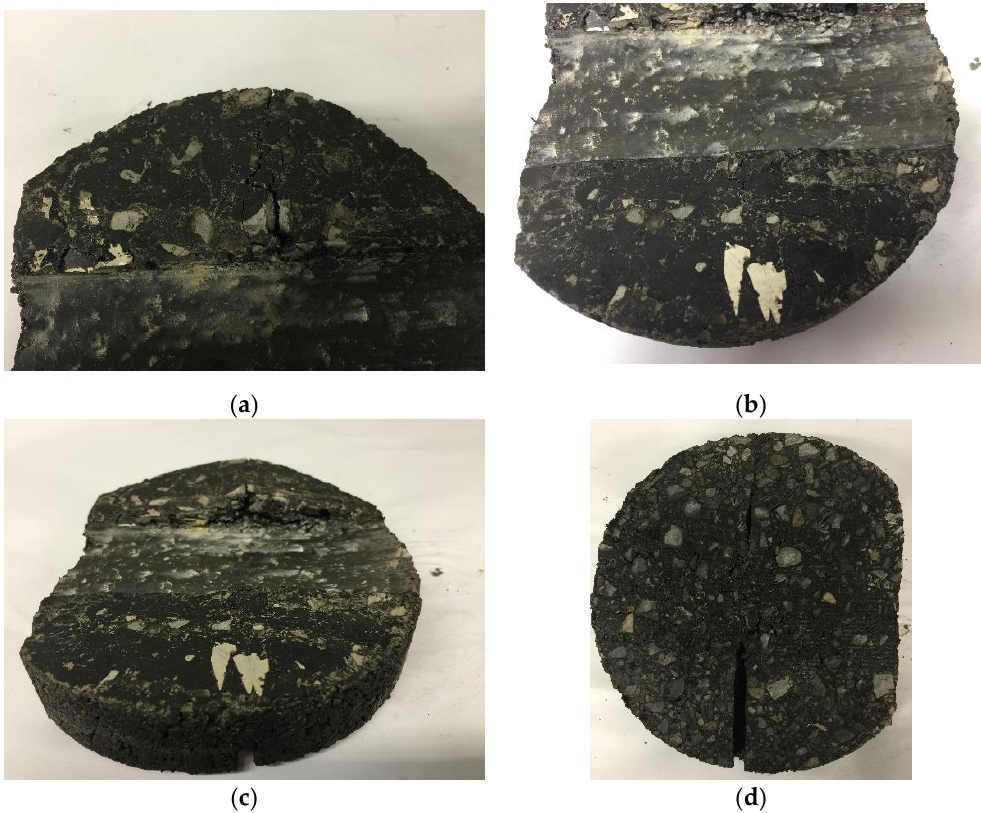
Figure 5. Specimen #1 (1 inch thickness, 10 days aging, with a notch) with surface-initiated reflective cracking (SIRC), ( a ) specimen with propagated transverse crack; ( b ) transverse crack that initiates at the other side; ( c ) SIRC matches well with existing notch, and ( d ) specimen bottom.